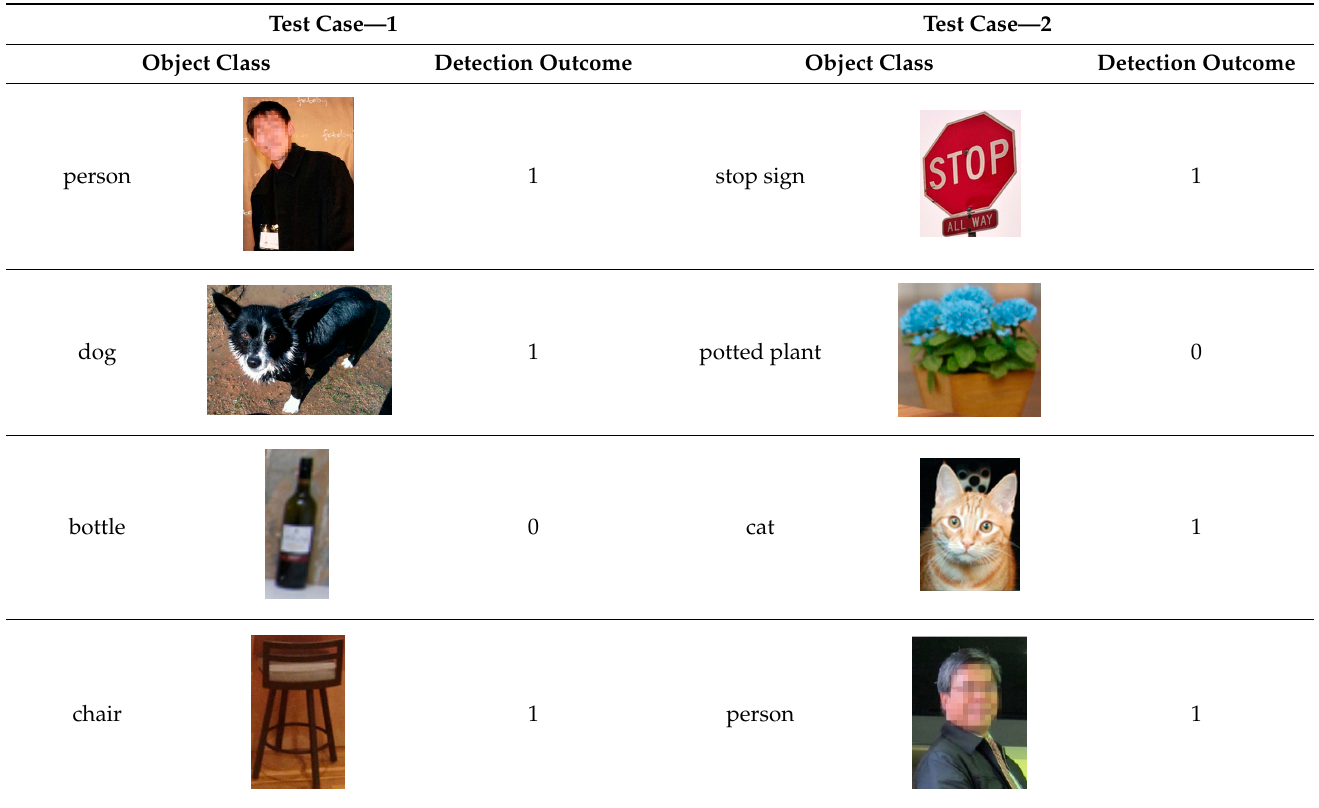
Table 4. Individual class performance (precision, recall, f1-score, support, and accuracy) for the trained one-class SVM